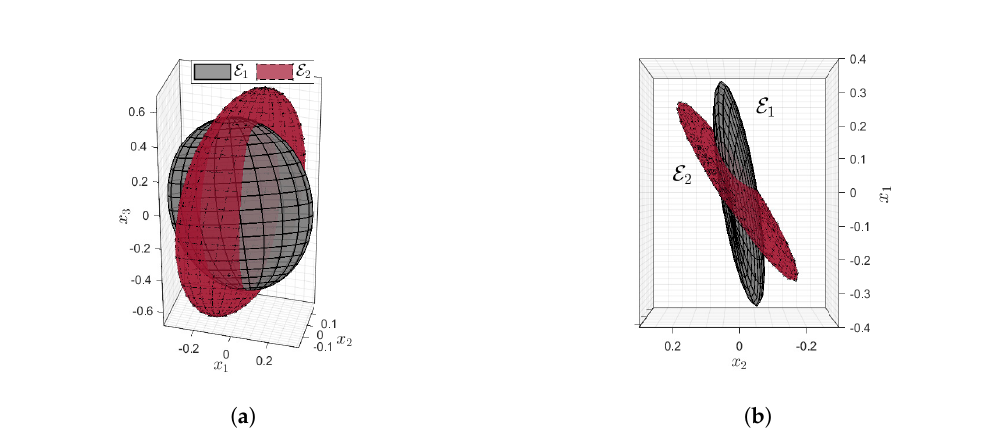
Figure 7. The invariant set E 1 and E 2 , E 1 , E 2 ∈ R 3 , i = 1,2, for system (18) where they are is plotted